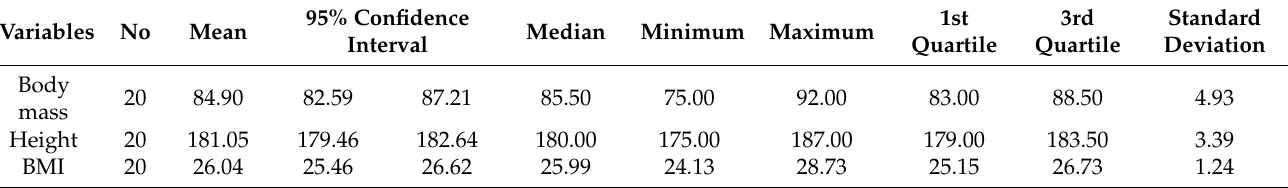
Table 1. Anthropometric characteristic of the